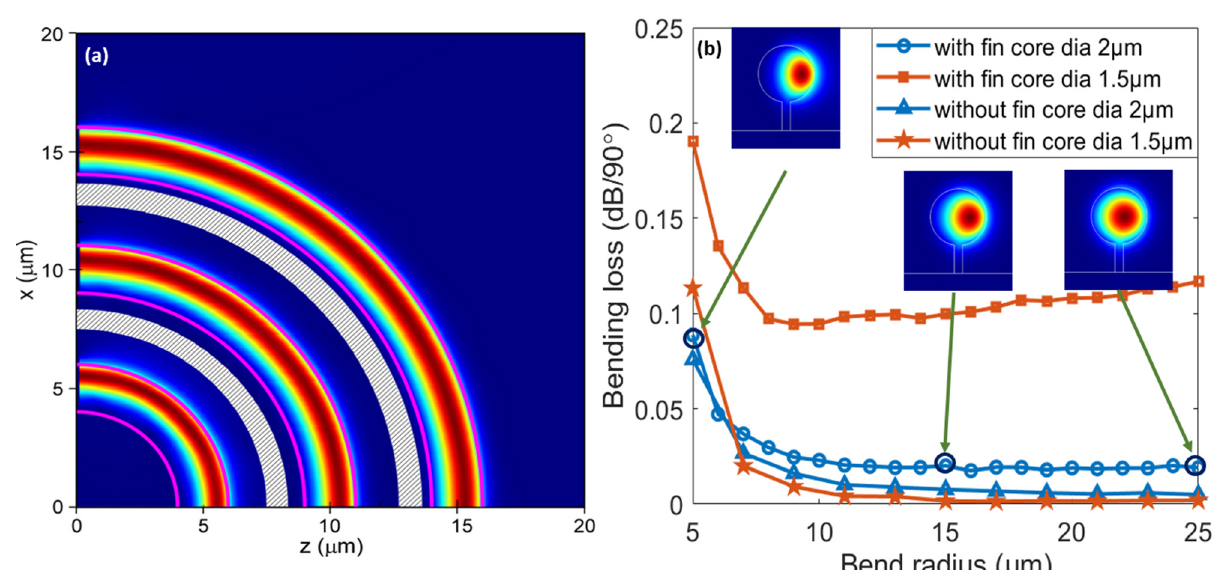
Figure 4. ( a ) Top view of the electric field modulus propagation through three 90° bent waveguides of 2 µm diameter, with bend radii of 5, 10, and 15 µm (composite view, separated by hatched pattern). ( b ) Bend loss as a function of bend radius for waveguide diameters of 1.5 and 2 µm, with and without nano-fin support. Insets show intensity profiles in bent waveguides of radius 5, 15, and 25 µm.